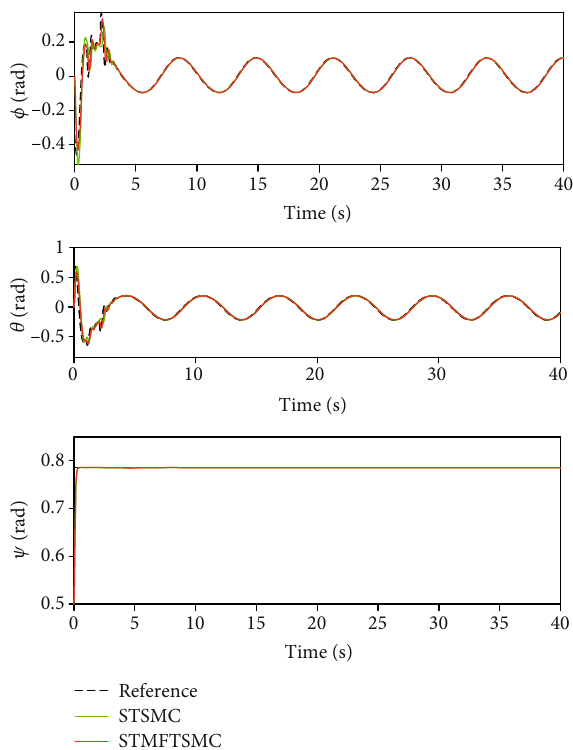
Figure 5: Quadrotor attitude ð ϕ , θ , ψ Þ